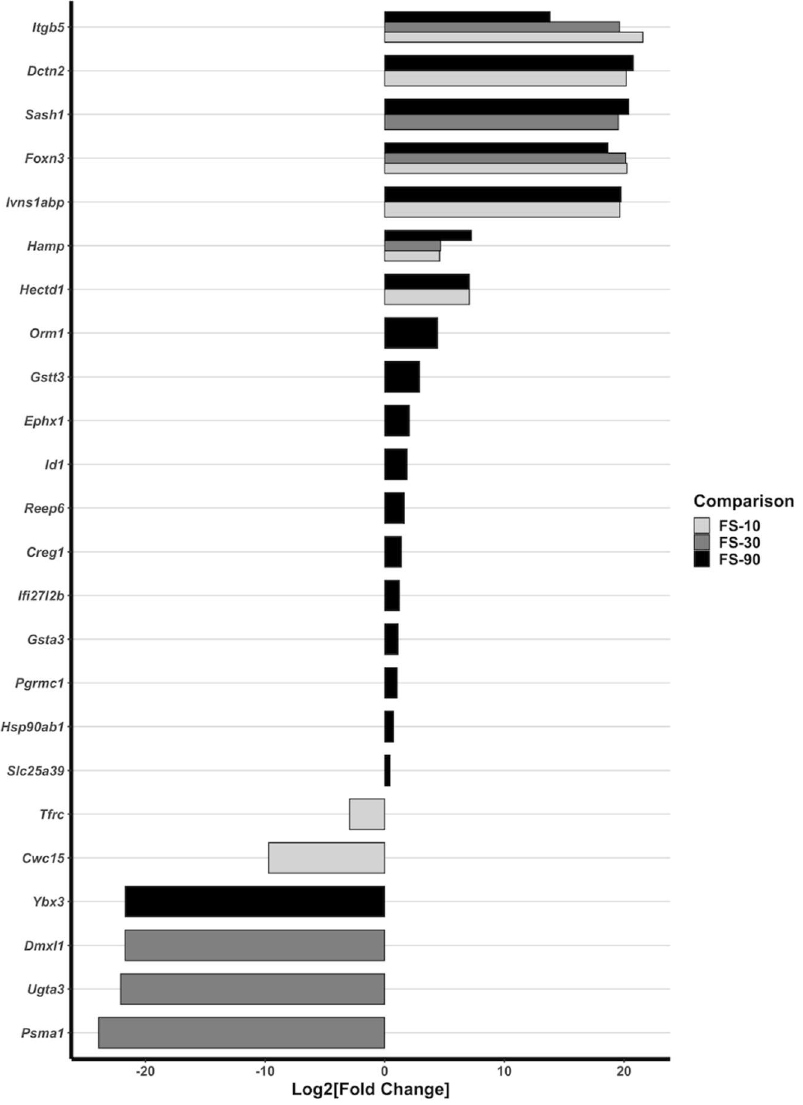
Figure 5. Hepatic mRNA expression is differentially modulated by FS supplementation. All genes determined to significantly different between CON and FS-10, FS-30, or FS-90 are displayed. Data is arranged on the y -axis in ascending order of expression magnitude relative to CON. Log2[Fold Change] values ( x -axis) were determined with DESeq2, and FDR-adjusted p -values < 0.05 were considered